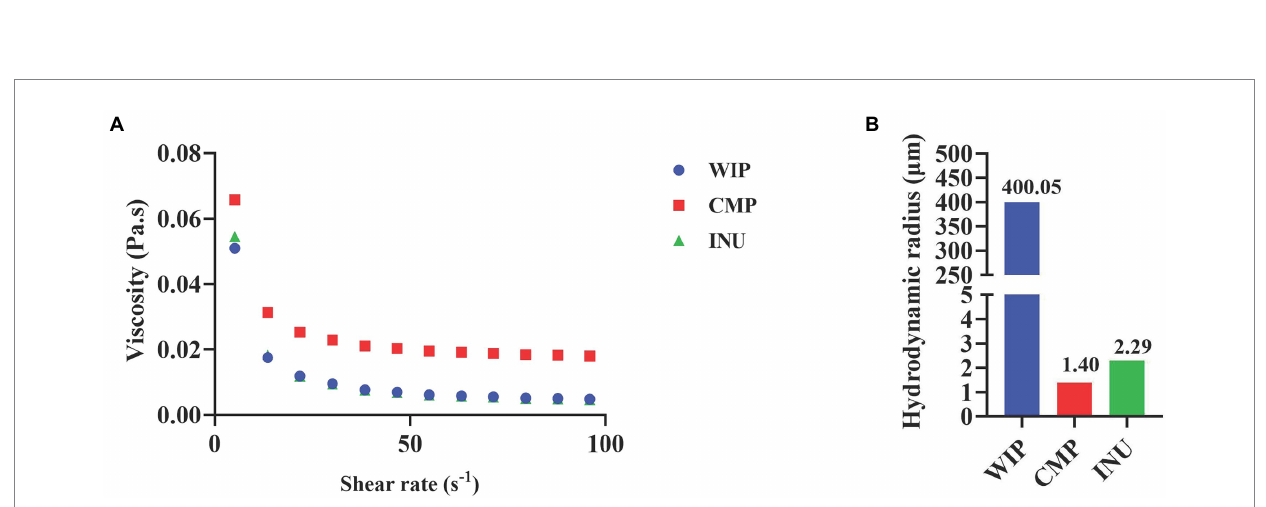
FIGURE 4 Viscosity and osmotic activity of WIP. (A) Viscosity, (B) particle size of WIP, CMP and INU.